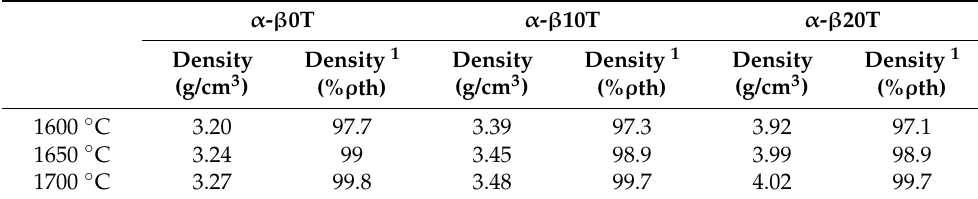
Table 2. Densities of SPSed composites.